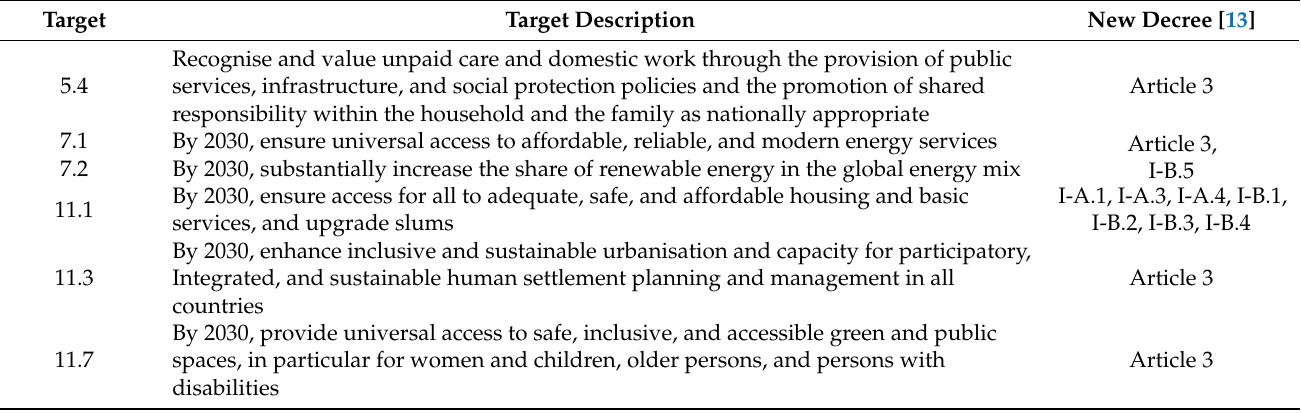
Table 2. SDGs and their implicit treatment in the new Habitability Decree of